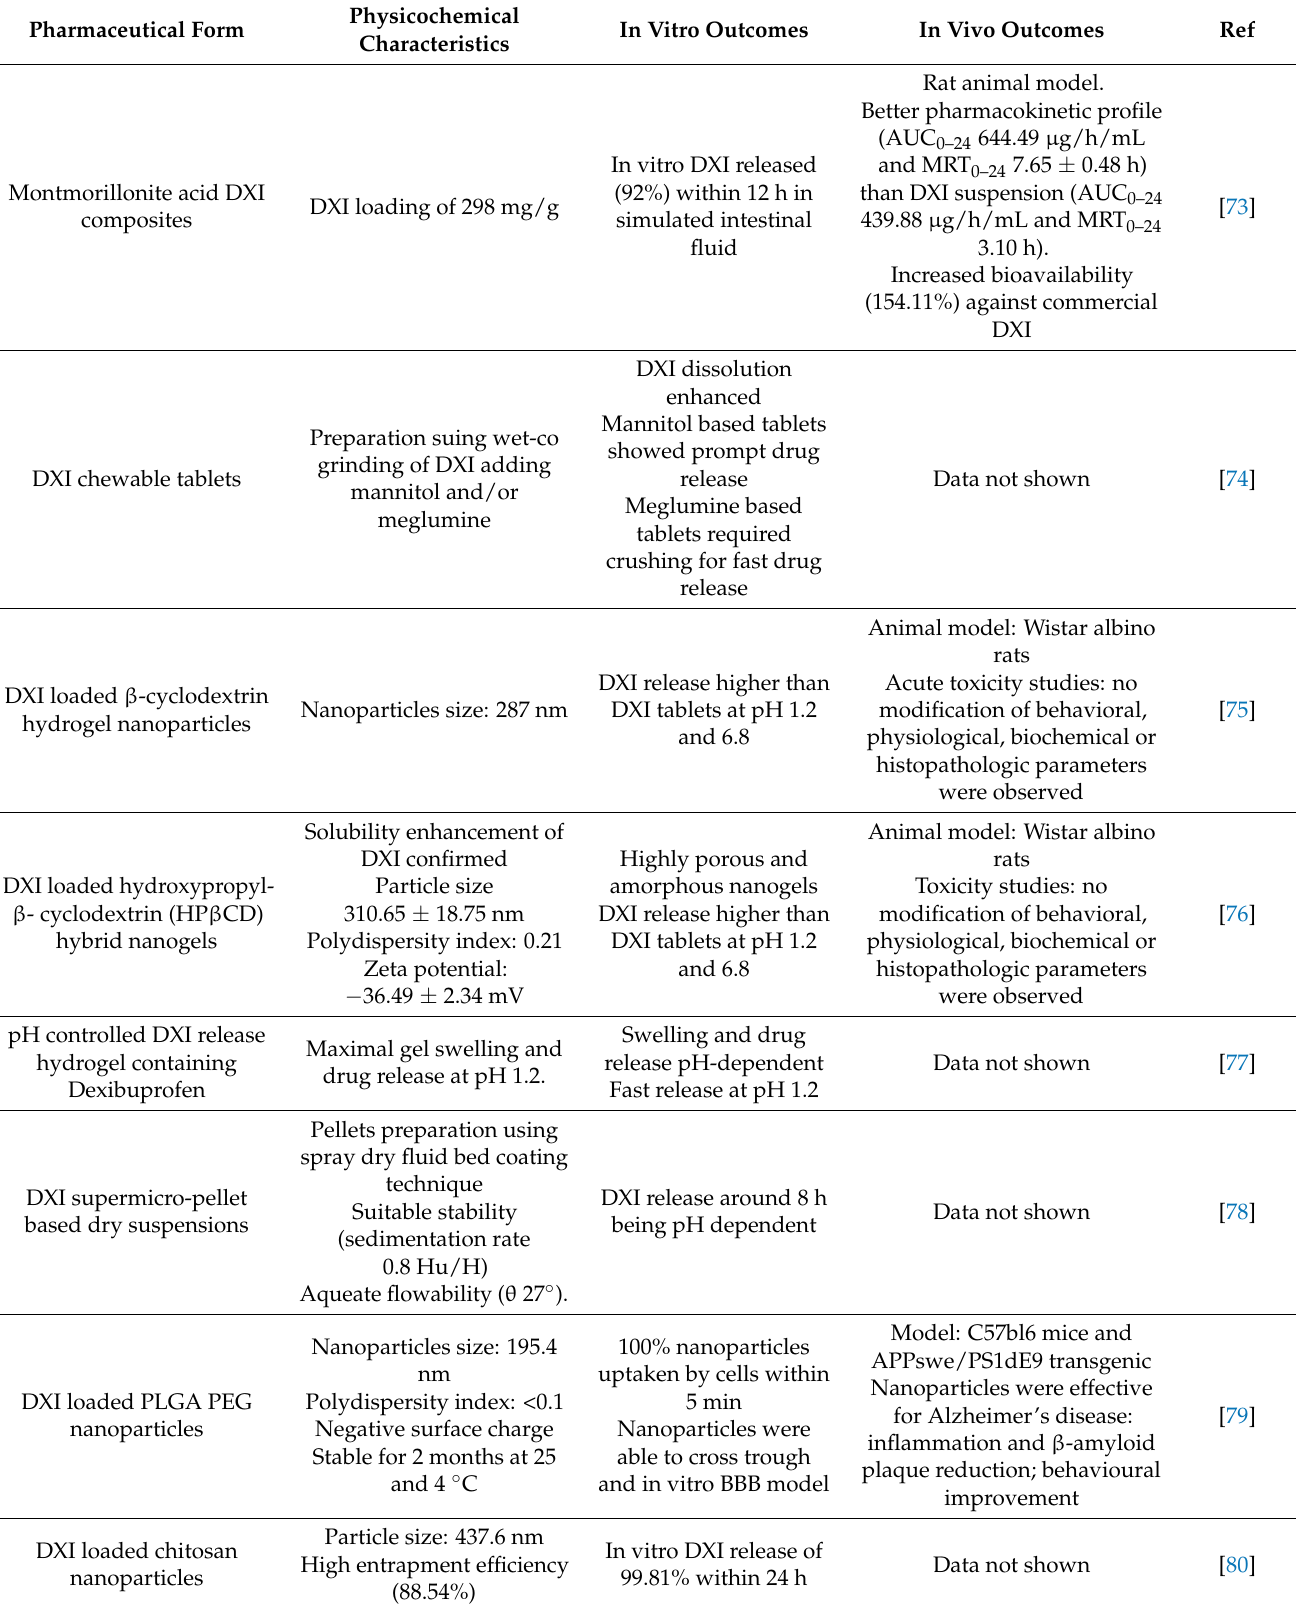
Table 2. Oral DXI drug delivery systems (AUC, area under the curve; MRT, mean residence time; C max , maximum plasmatic concentration, T max , time to achieve maximum plasmatic